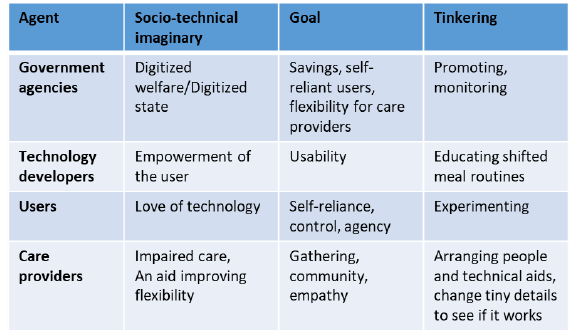
Table 1. Implementation of FAR - agents, sociotechnical imaginaries, goals and